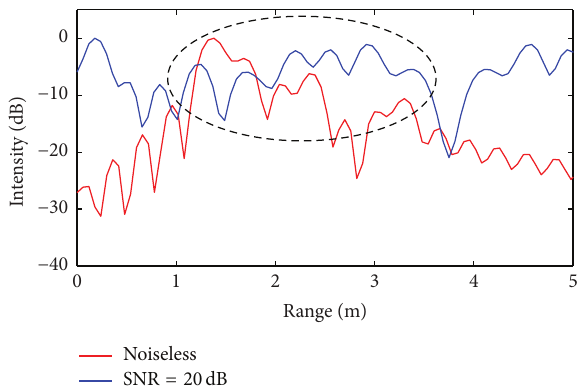
Figure 11: Range profile obtained from CS procedure (comparison between noiseless and Gaussian corrupted case, second scenario: 6 targets): all targets are revealed in the presence of noise (SNR = 20 dB).